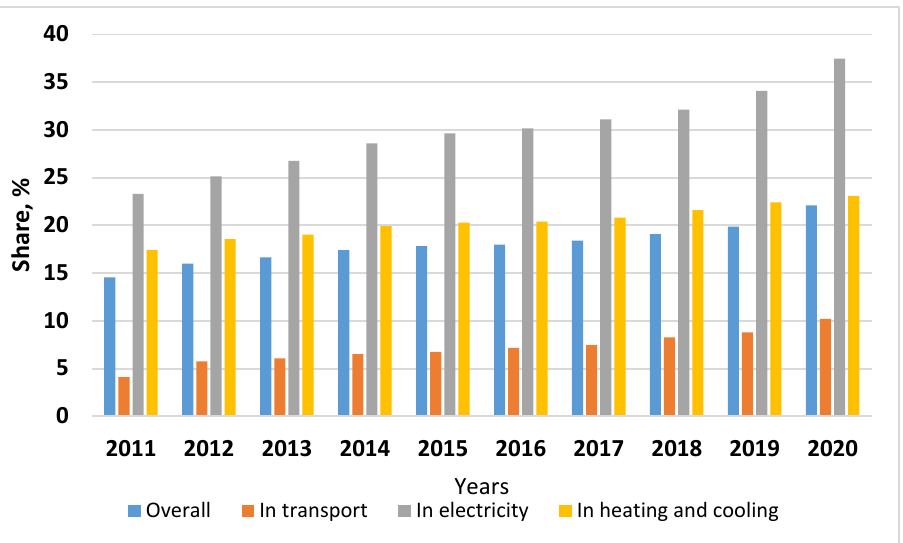
Figure 2. Share of energy from renewable sources in the EU (2011–2020), developed by authors using